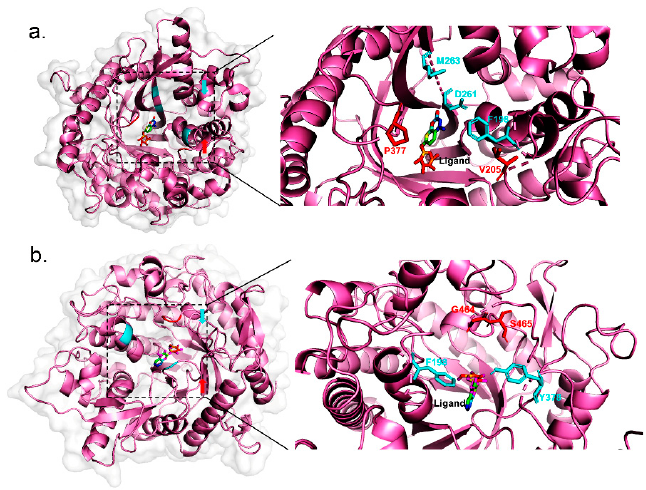
Figure 3. View of predicting effects of residue mutation on the catalytic efficiency of the glycoside hydrolysis reaction. Regions of mutated sites that increase/decrease catalytic efficiency are highlighted in red/cyan on the cartoon. Ligand is shown as sticks in the rainbow. ( a ) Beta-D-glucosidase 1, Maize (PDB:1HXJ). ( b ) Beta-D-glucosidase, Rye (PDB:3AIU).